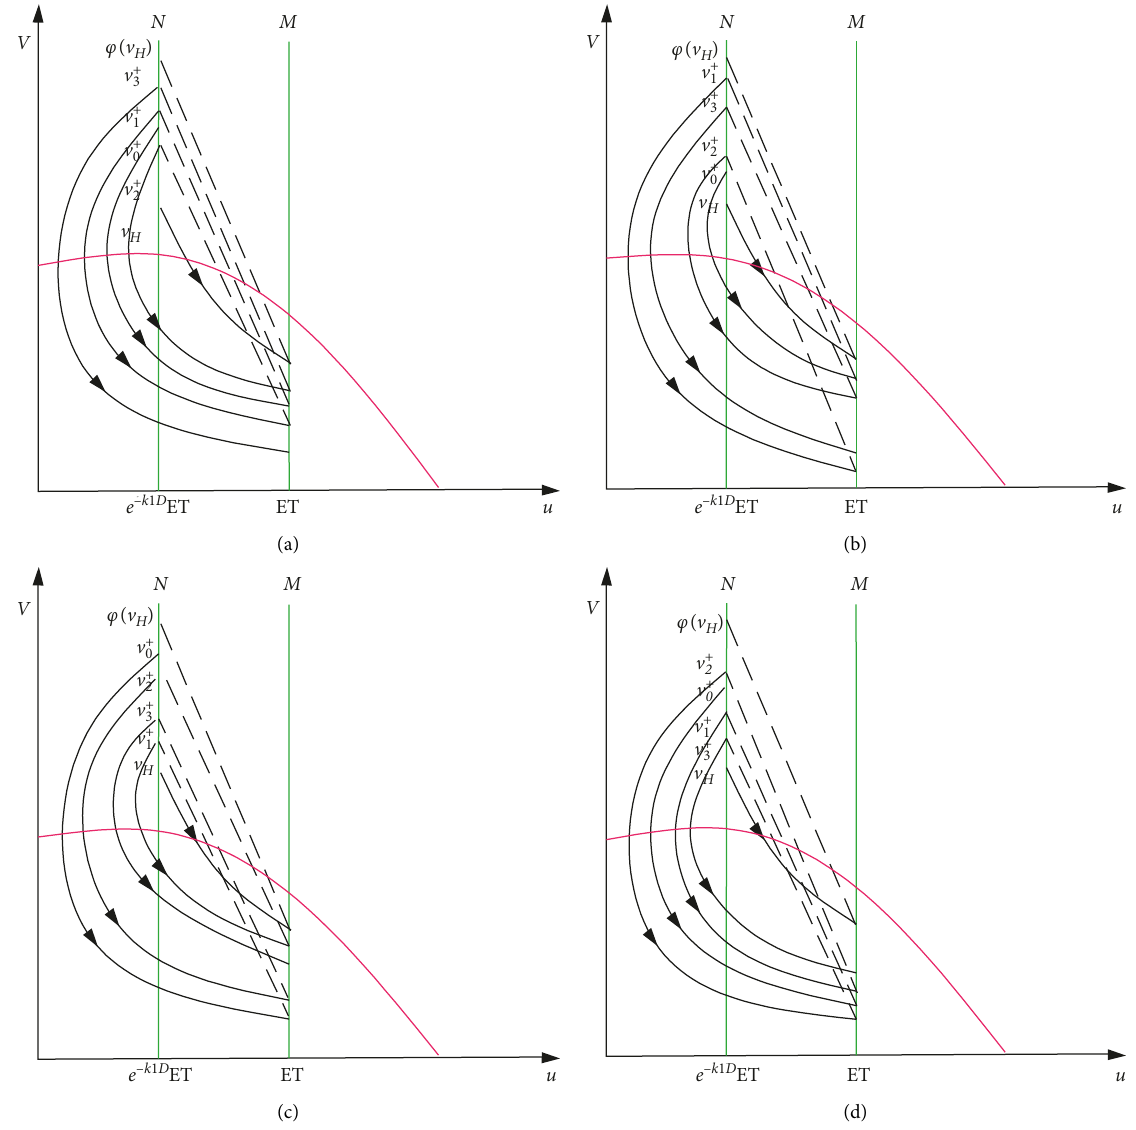
Figure 2: Four cases of existence of periodic solutions in Theorem